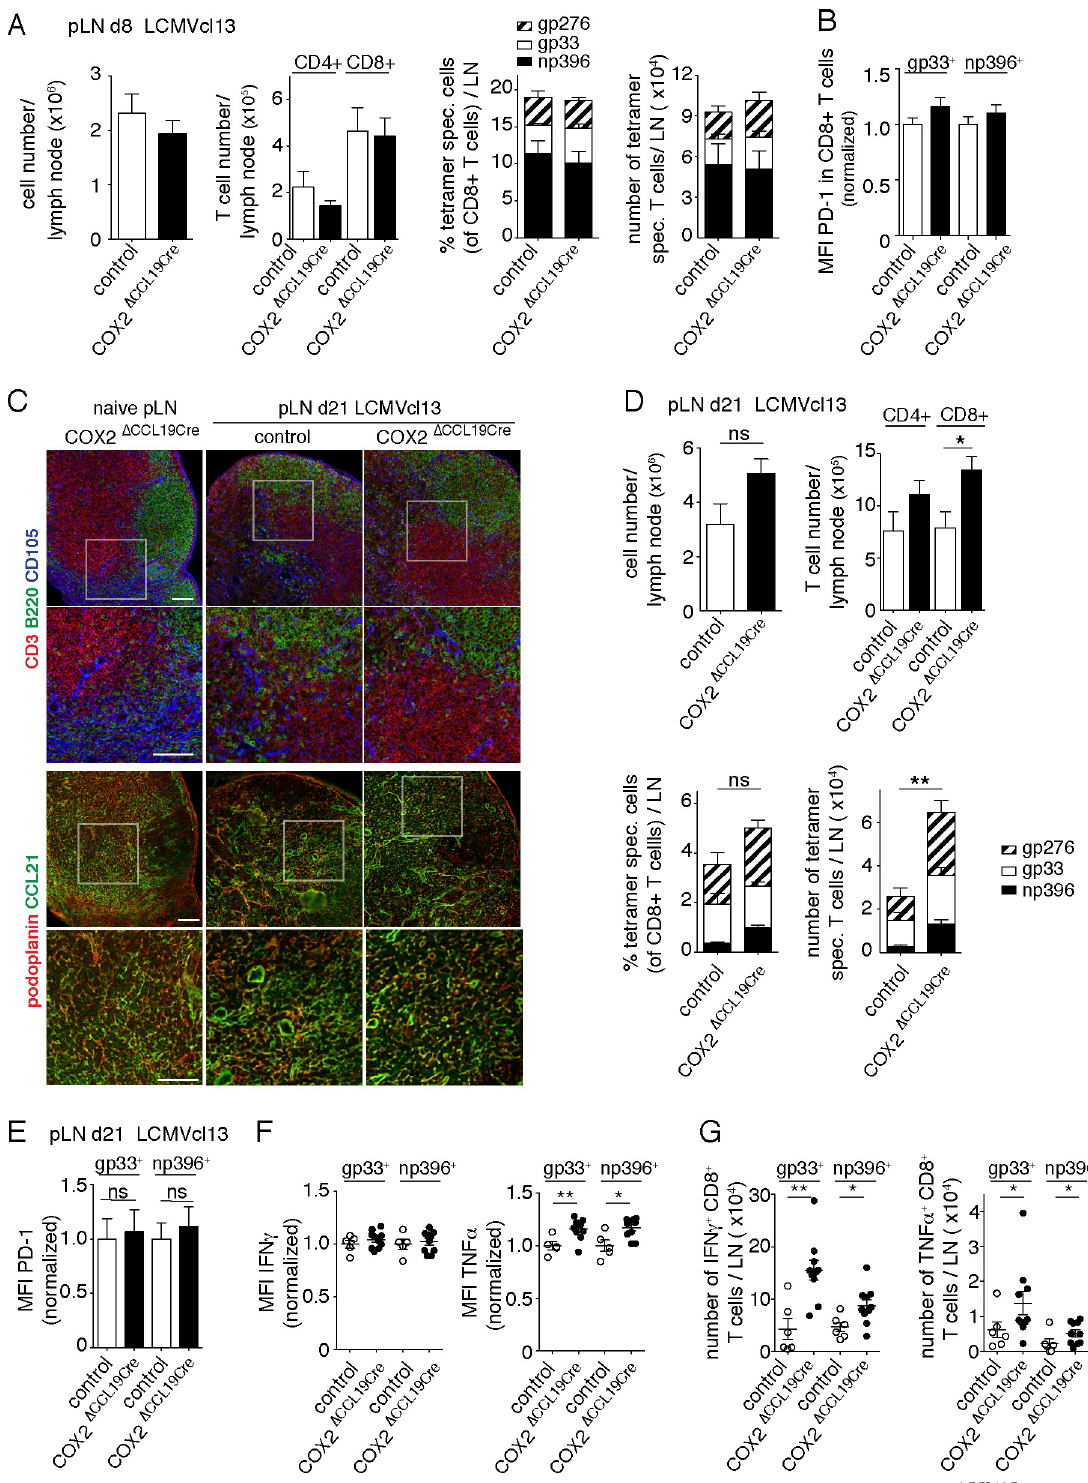
Fig 4. COX2 activity in FRCs dampens chronic T-cell responses during nonresolved LCMV infection in vivo. COX2 Δ CCL19Cre and littermate control mice were infected with LCMV clone 13 and analysis performed in draining pLNs at d 8 (A–B) or d 21 (C–G). (A) Bar graphs showing total cell numbers and T-cell numbers per pLN, as well as the percentage and number of LCMV-specific CD8+ T cells in the indicated mice 8 d after LCMV clone 13 infection. (B) MFI of PD-1 expression on gp33- versus np396-specific CD8+ T cells, with